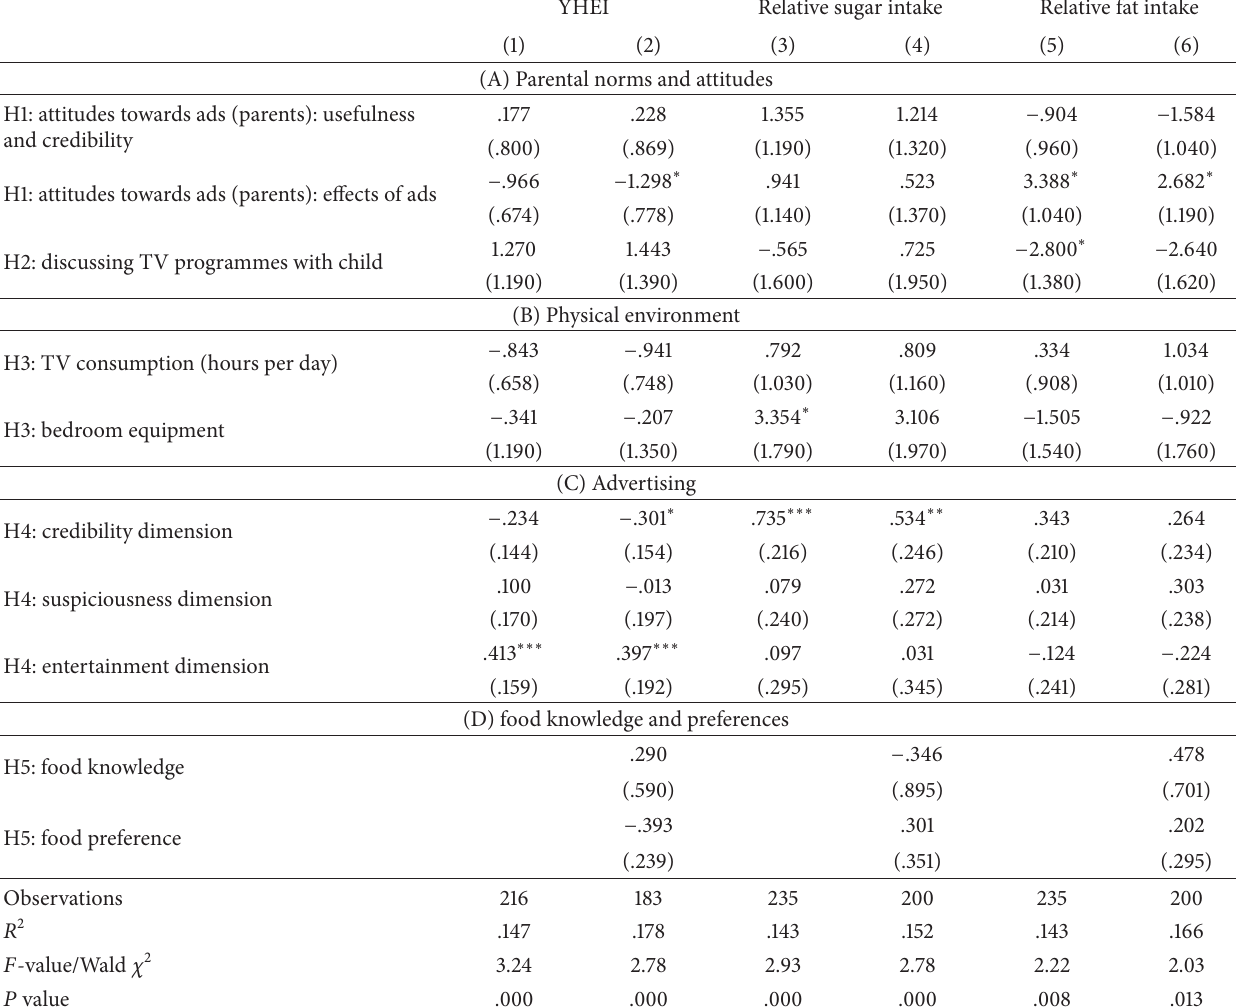
Table 3: Role of commercials on diet: